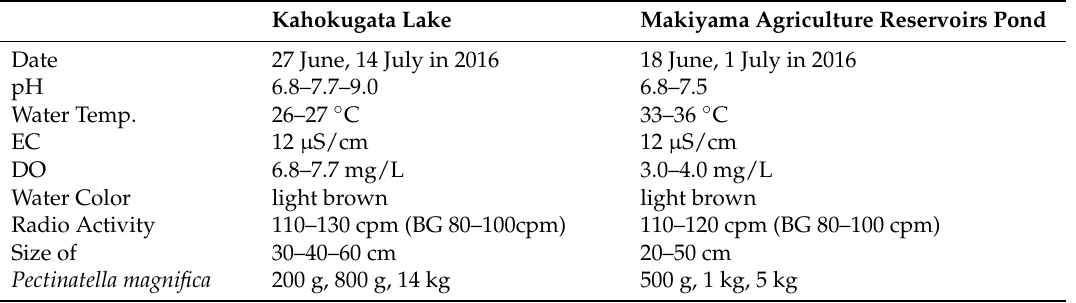
Table 1. Characteristics of water in Kahokugata Lake and Makiyama Pond in 2016. EC: electrical conductivity; DO: dissolved oxygen; BG: Back